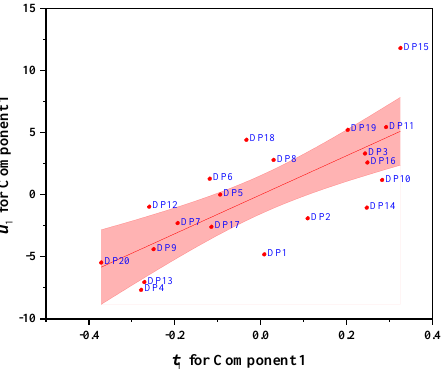
Figure 6. Regression plot between t and v in component 1 with an eccentricity factor.